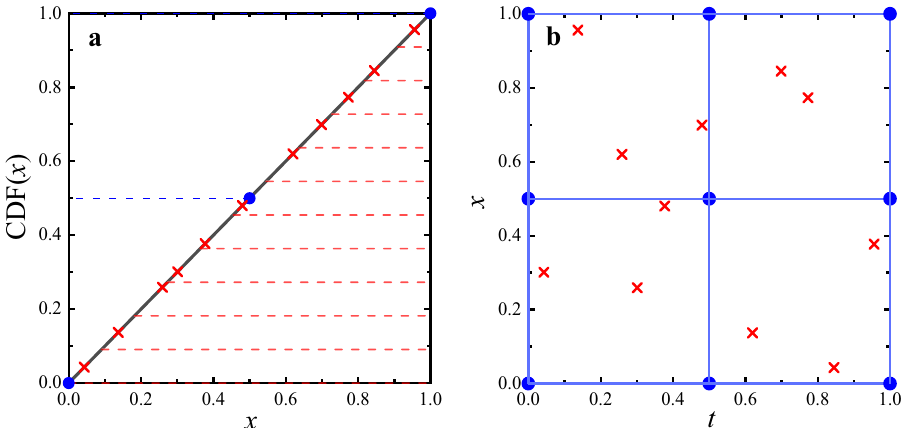
Figure 2. The data sampling distribution of GLHS. Take a total of 20 data, 2 dimensions, each dimension in the domain of [0,1] as an example. The blue dots represent the Cartesian grid data points and the crossed dots denote the data in LHS. ( a ) The data sampling on each dimension; ( b ) The overall data distribution after mixing.